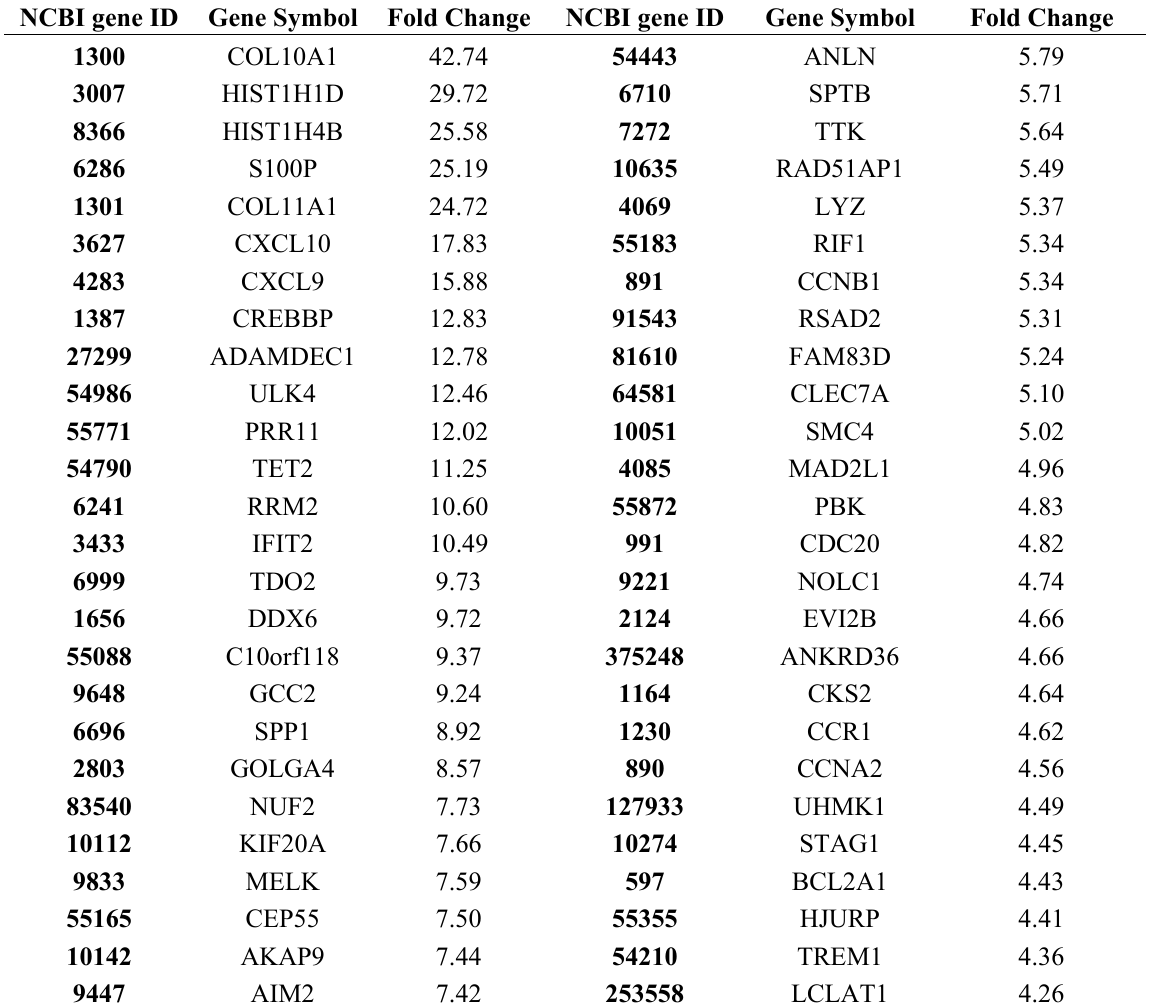
Table S1. Up-regulated genes found in dataset GSE29174. There are 437 up-regulated genes in this list. Q -values reported by SAM were 0 for all genes in this